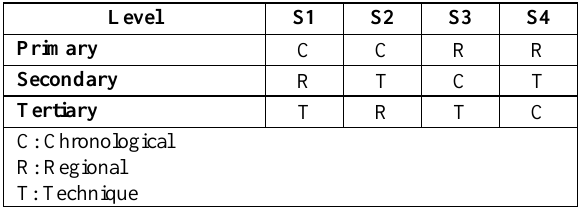
Table 5. Options for structuring a New Zealand